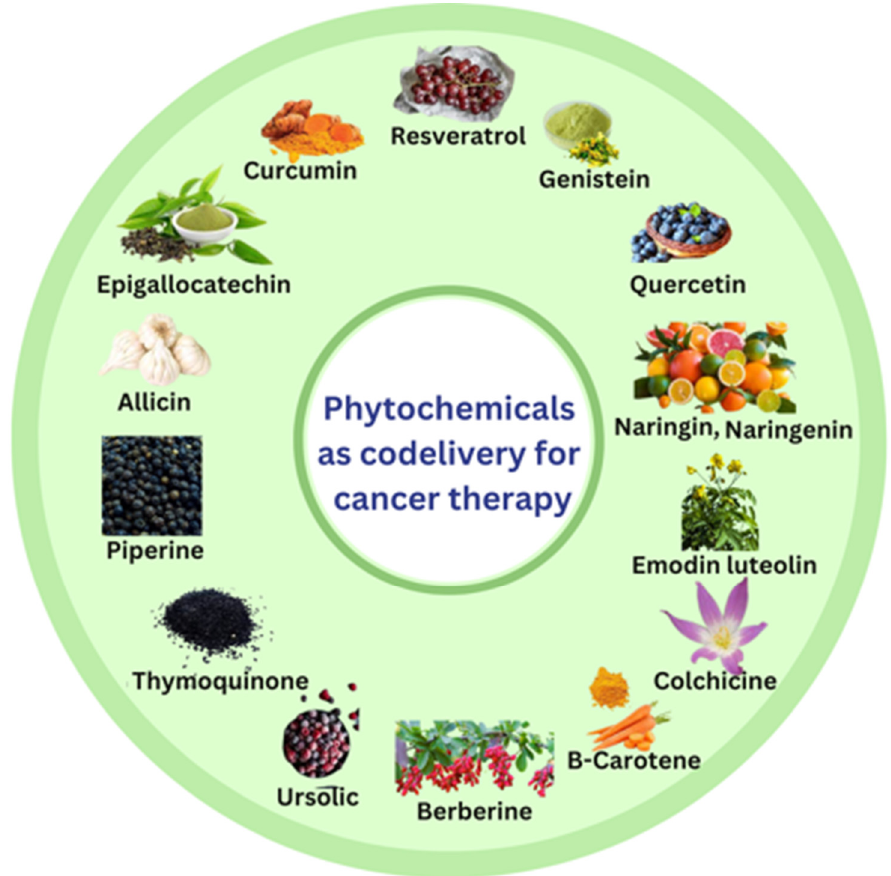
Figure 4. Various phytochemicals employed as codelivery with anticancer drugs